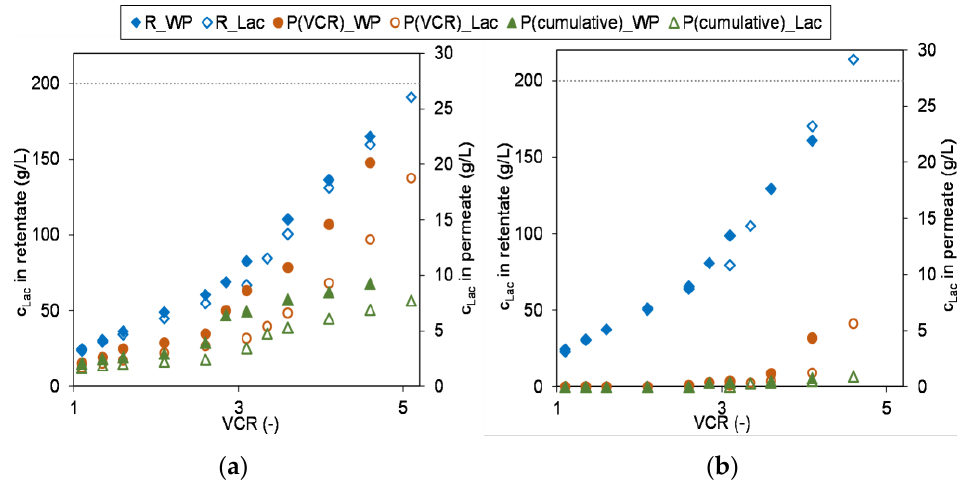
Figure 9. Evolution of lactose concentration in retentate (R), permeate (P(VCR)) and cumulative permeate (P(cumulative)) during the concentration of lactose model system (Lac) and whey permeate (WP); ( a ) membrane: XN45; ( b ) membrane: